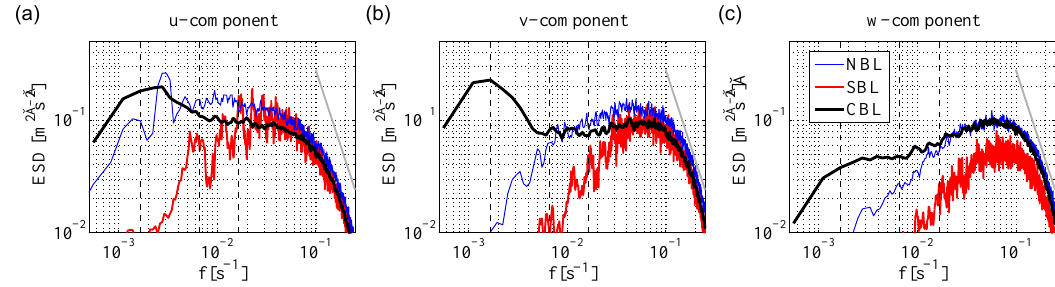
Figure 4. Energy spectral density of the three different wind components at hub height during the last hour of the precursor simulations. The gray line denotes the slope of the Kolmogorov cascade. Vertical lines are at T = 10min, 3min and 1min.